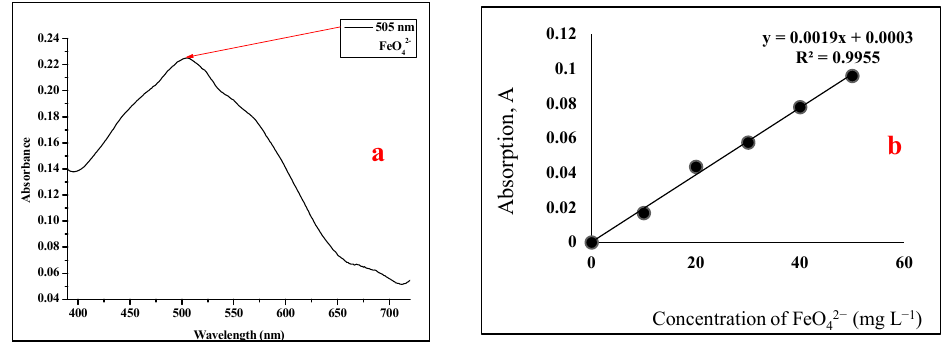
Figure 2. ( a ) Absorption peak of K 2 FeO 4 (FeO 42−- ) on UV-Vis and ( b ) calibration curve. Sodium ferrate (VI) with the chemical formula of Na 2 FeO 4 was successfully produced and quantified with the concentration of 12.40 g L −1 or 0.10 M (as FeO 42− ) (reading on UV- Vis: 0.0124 g L −1 multiplied by a dilution factor: 1000). The concentration was determined